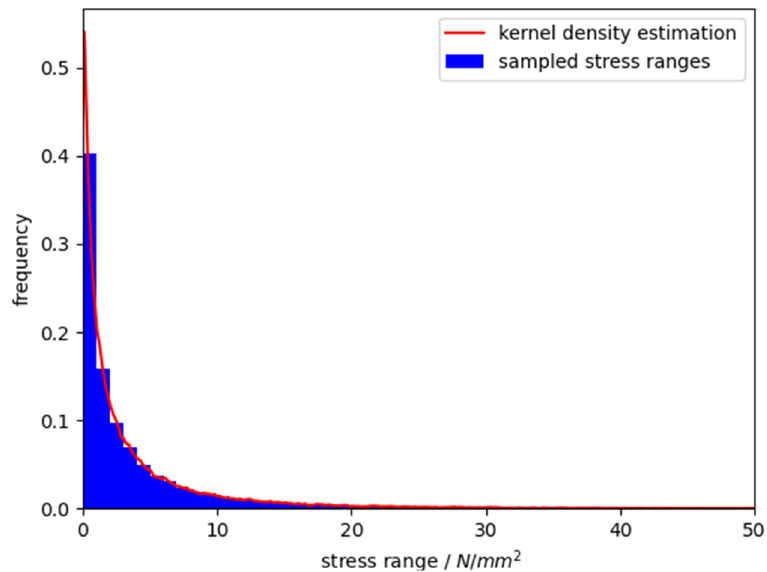
Figure 9. Histogram of the stress ranges based on strain measurements and the kernel density esti- mation, 𝑓(Δ𝜎 (cid:3014) |Δ𝜎 (cid:3005)(cid:3032)(cid:3046)(cid:3036)(cid:3034)(cid:3041) ) , at position 2 for a northerly wind direction. With the information from the prior stress ranges and stress ranges based on strain